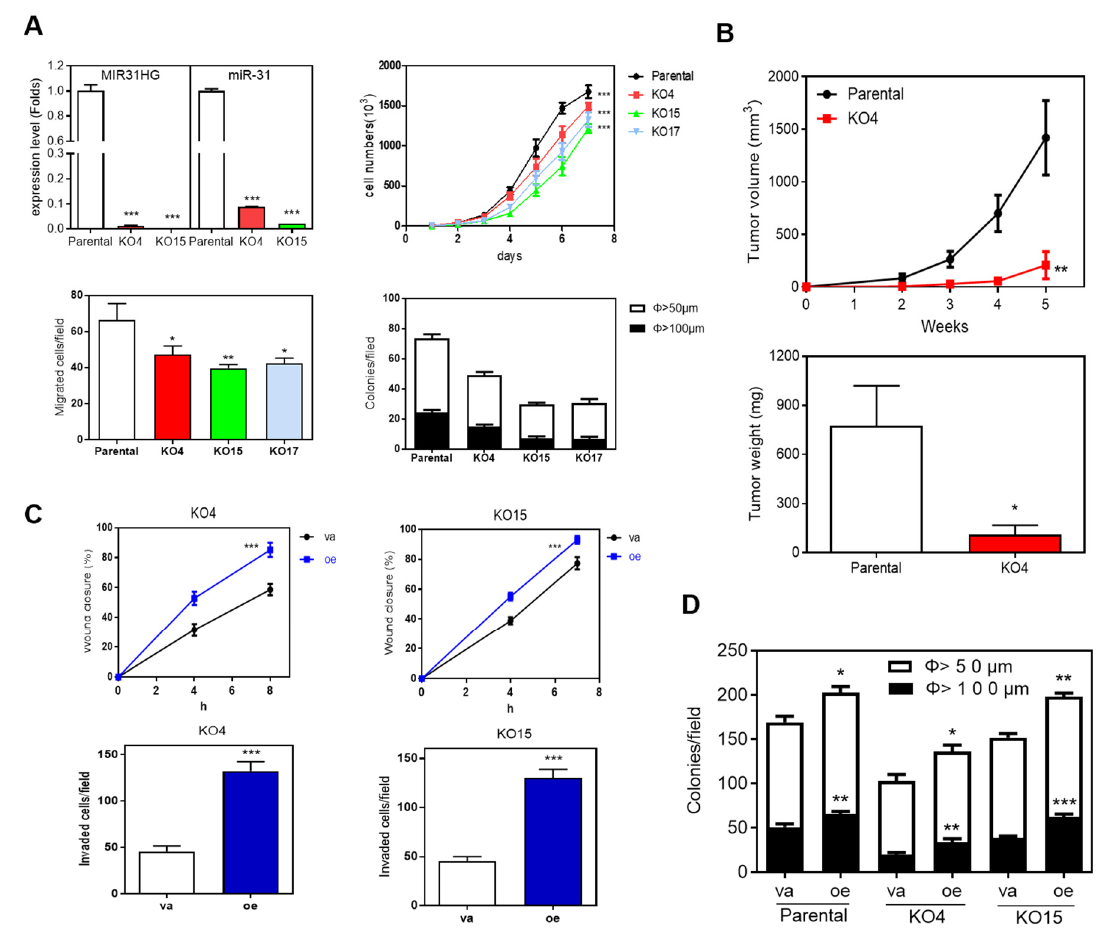
Figure 4. MIR31HG overexpression rescues the suppression brought about by the knockout of MIR31HG in SAS cells. ( A ) Association between MIR31HG knockout and decreased oncogenicity. Upper Left, the decreased expression of MIR31HG and miR-31 in the knockout cell subclones KO4 and KO15. Upper Right, Lower Left, and Lower Right, the decreased growth, invasion, and colony formation in the knockout cell subclones KO4, KO15, and KO17 relative to parental cells, respectively. ( B ) Subcutaneous tumorigenesis assay. Upper, the growth curve of tumors over a 5-week period. Lower, the weight of the resected tumors. ( C ) Using the KO4 (left panel) and KO15 (right panel) cell subclones, transient MIR31HG overexpression increases the wound closure rate (upper panels) and tumor cell invasion (lower panels). ( D ) Anchorage-independent colony formation assay. In the parental cells, the KO4 cell subclone and the KO15 cell subclone, transient MIR31HG overexpression increases colony formation. va, vector alone, oe, transient MIR31HG overexpression. *, p < 0.05; **, p < 0.01; ***, p < 0.001.